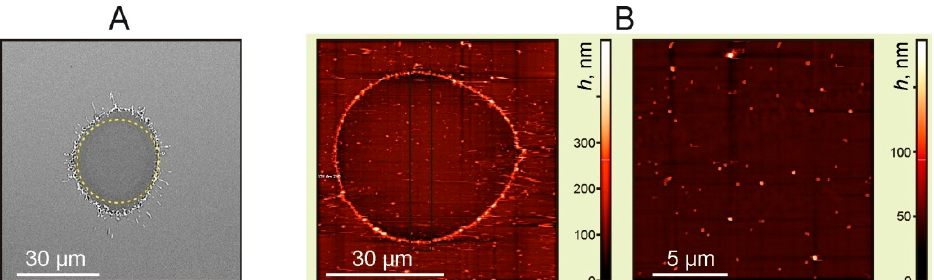
Figure 3. Images of the Ti film with a thickness of 50 nm after laser exposure. ( A ) SEM image. The dotted line shows a circle with a diameter of 30 μ m, E = 7 μ J ( F = 1 J/cm 2 ). ( B ) AFM images of the ablated areas, E = 24 μ J ( F = 3.4 J/cm 2 ).